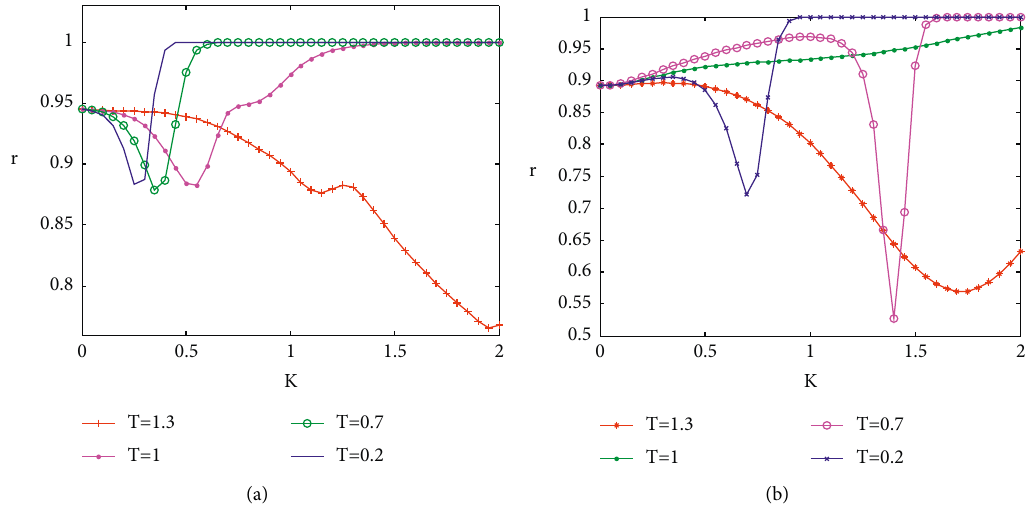
Figure 7: The order parameter evolution of oscillatory network under different values of time delay: (a) ring network and (b) chain network.